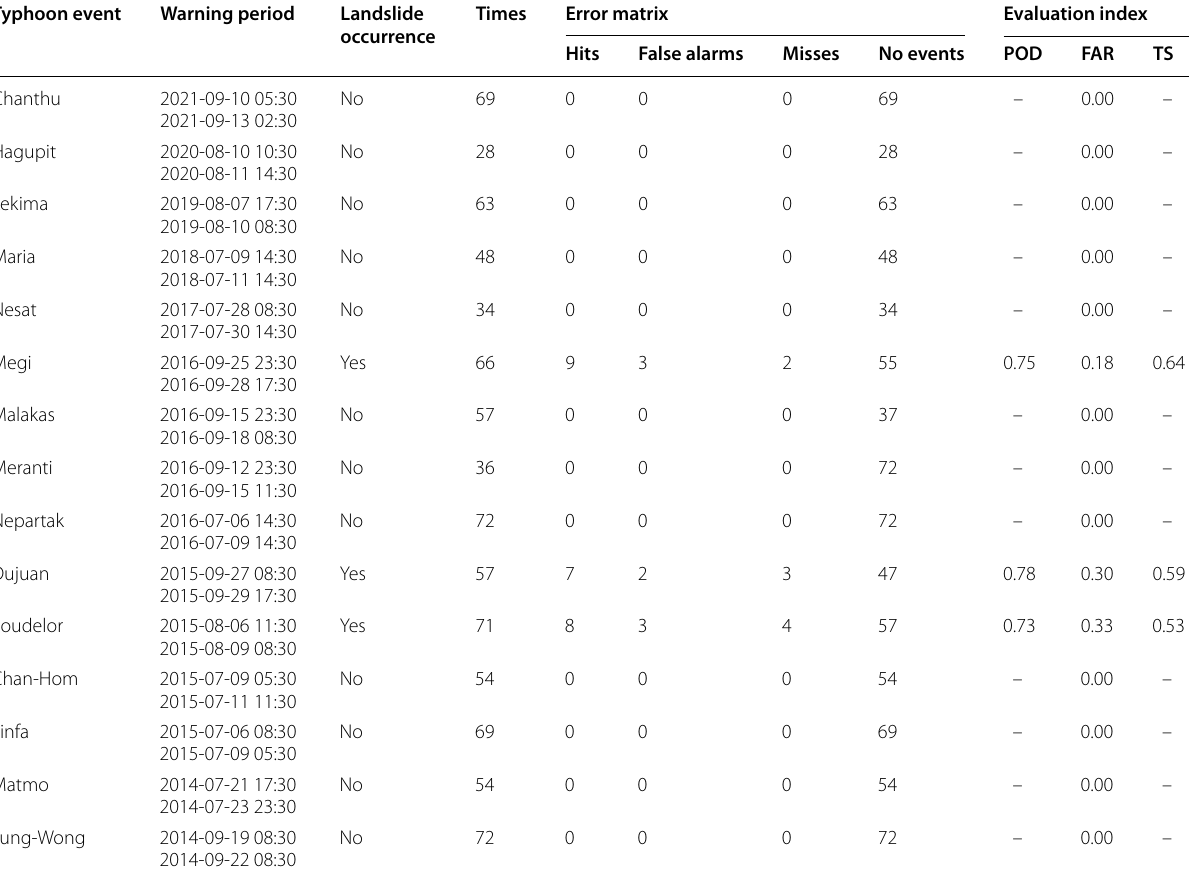
“–” denotes unavailability of POD and TS because the typhoon did not cause any landslides